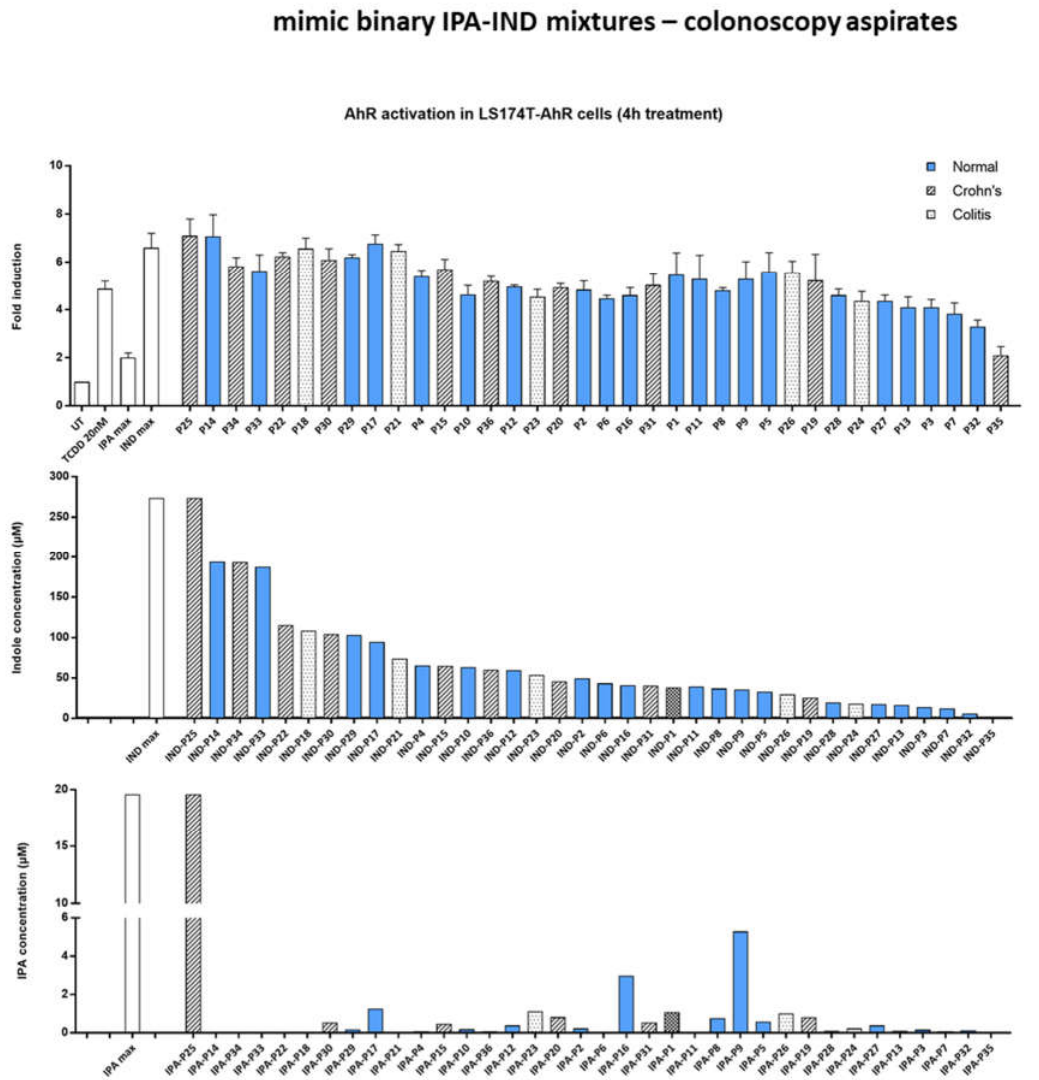
Figure 6. AHR activation by mimic binary mixtures of IND and IPA. LS174T-AHR-luc cells were incubated for 4 h with vehicle (DMSO; 0.2% v/v), TCDD (20 nM), and the tested compounds alone or in the mixture. Mimic binary mixtures were prepared according to the ratio of IND and IPA that equals the concentration detected in individual aspirates of colonoscopy patients. The experiments were performed in technical quadruplicates and three biological replicates.